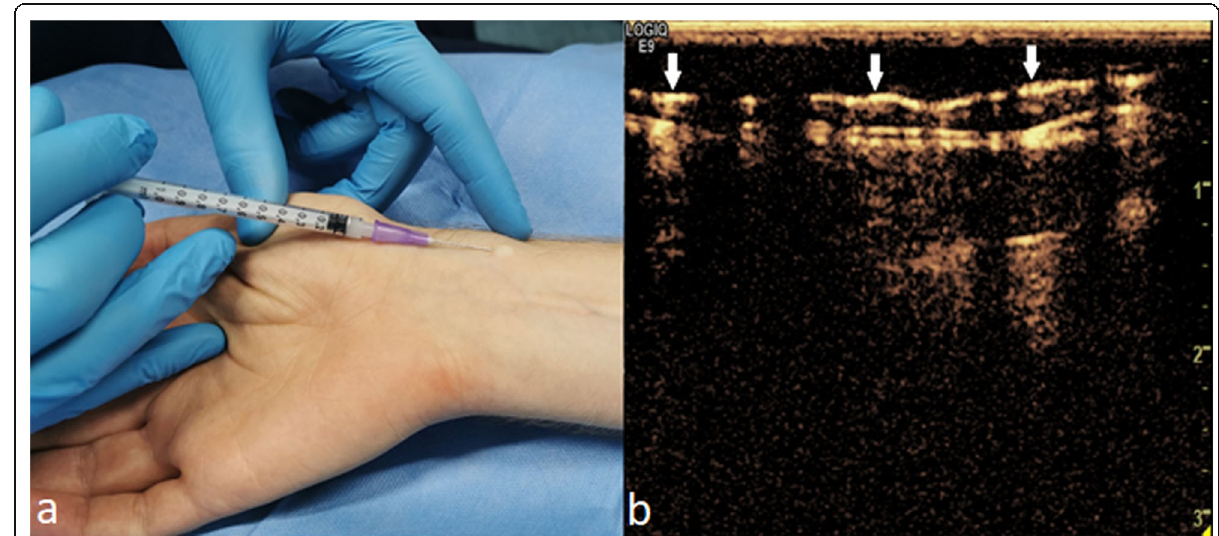
Fig. 1 a Injection site in the distal antebrachium and intradermal injection technique. A small blister-like spot beneath the skin in addition to resistance to injection are probable indicators of a successful injection. Contrast agent (Sonazoid®, white arrows) can be seen in the superficial